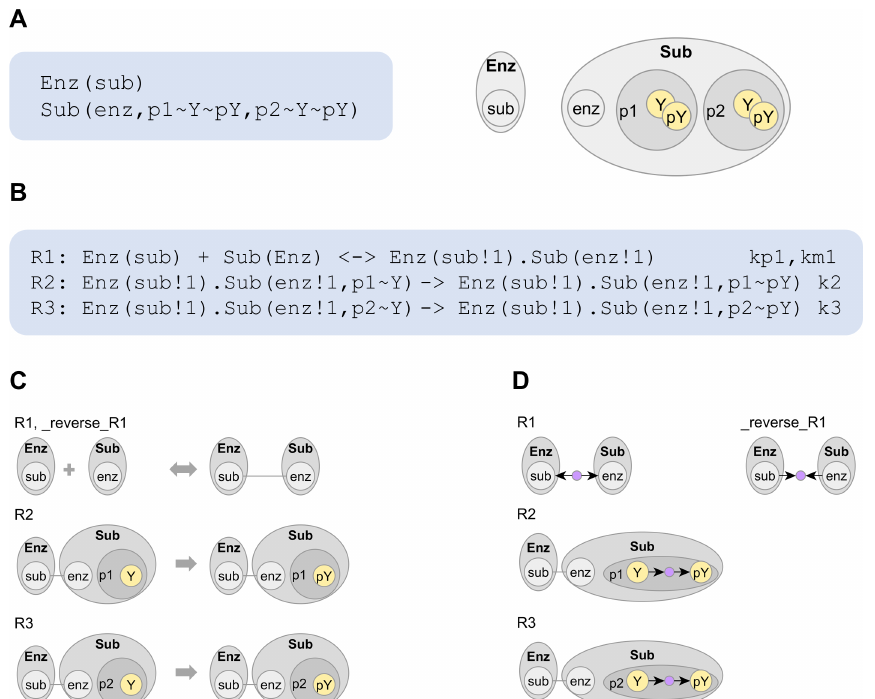
Fig 2. Visualizing rules of an enzyme-substrate system. (A) Structured moleculetypes Enz and Sub, their respectivecomponents (enclosedin ‘()’) and their availableinternalstates (prefixed by ~), shown in BioNetGen syntax and graphic.(B) Reactionrules specifying the addingand removingof an enzyme- substrate bond (bindingpartners taggedby !1) and phosphorylation of components p1 and p2 , shown in BioNetGen syntax. The reactants and products of a reaction rule are called patterns. (C) Conventional rule visualizationby drawingreactant and product patterns separately. (D) Compact rule visualizationdisplays operations(purple nodes)that transform the reactant patterns in each rule. On operationnodes, outward edgesindicate that a new structure is produced (bond in R1, state pY in R2 and R3) and inwardedges indicatethat a structure is consumed (bond in _reverse_R1, state Y in R2 and R3). To see operationnodes with their labels, see S1 Fig.